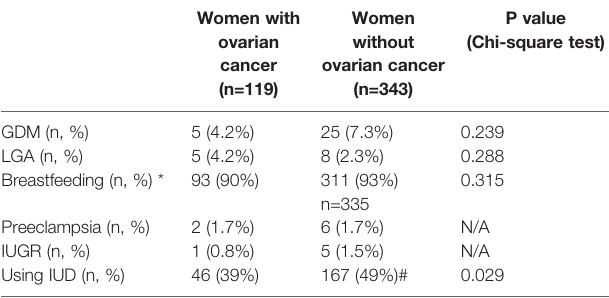
TABLE 3 | The association of complications of pregnancy and ovarian